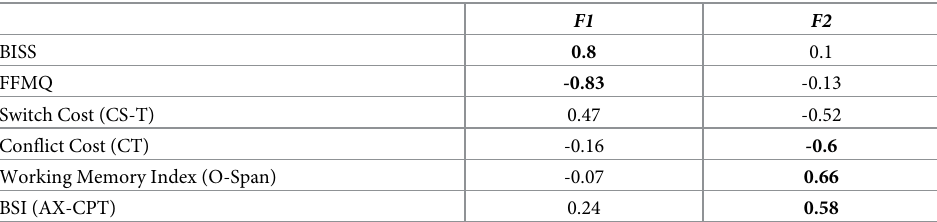
Table 3. Factor loadings of the main